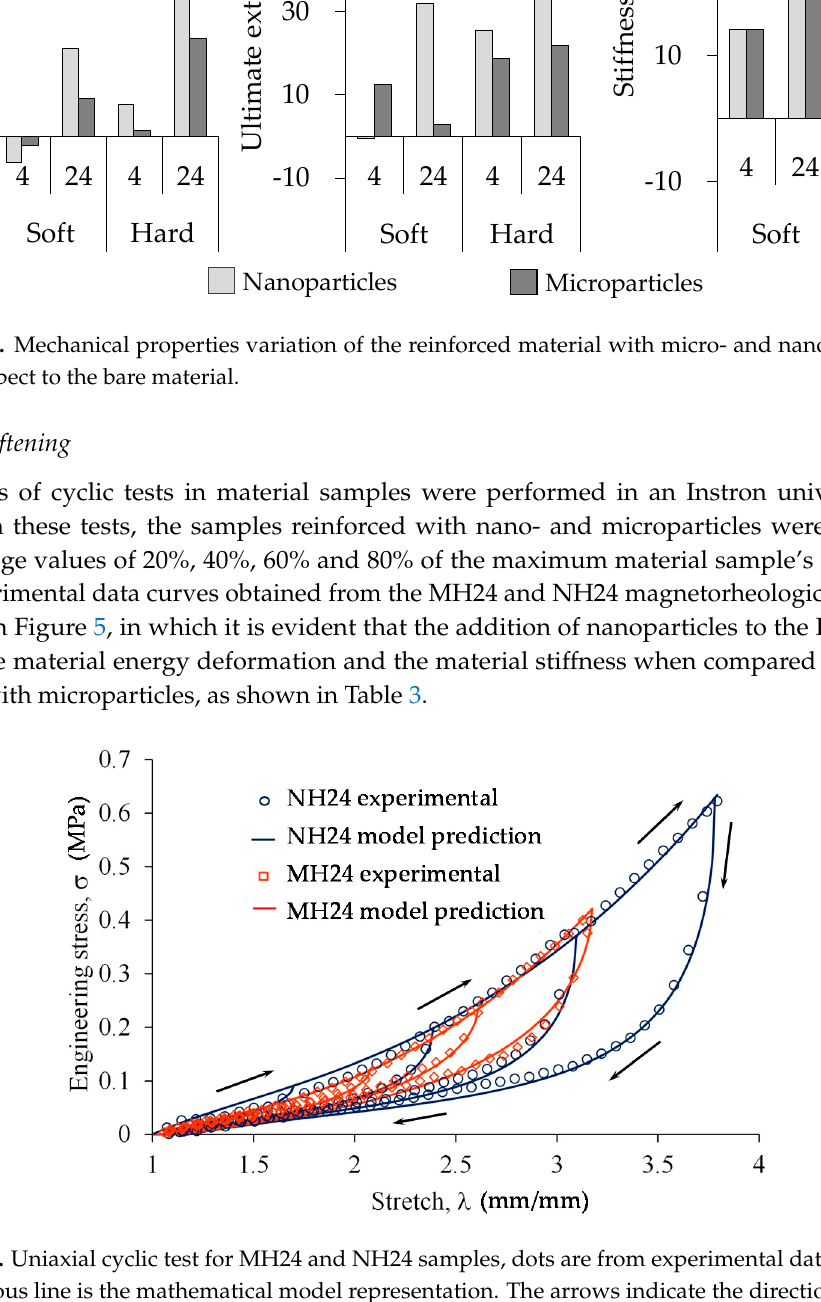
Figure 3. Mechanical properties variation of MRE samples when the SO content is increased from 4%